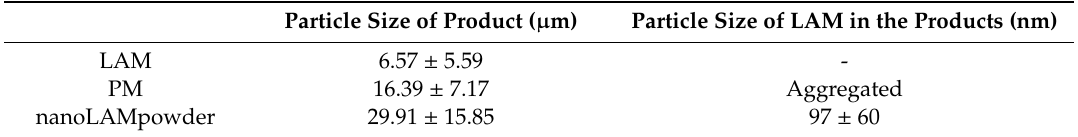
Table 1. The particle size of the products